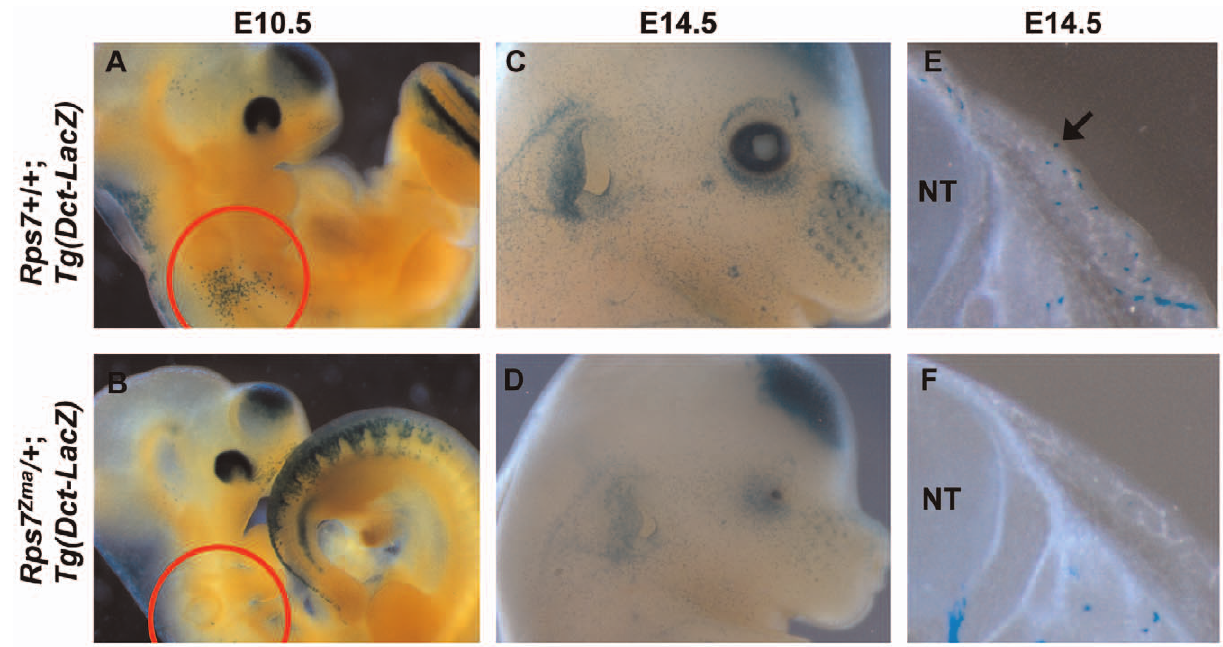
Figure 6. Melanoblast numbers are reduced in Rps7 Zma / + mutants. (A, B) In transgenic embryos carrying the melanoblast reporter Tg(Dct- LacZ) , whole mount staining showed that Dct-positive melanoblasts are significantly reduced at E10.5 in Rps7 Zma / + ; Tg(Dct-LacZ) mice (A) compared to Rps7 + / + ; Tg(Dct-LacZ) littermates (B). The reduction is noticeably apparent over the otic region (red circle). (C,D) Whole mount staining of E14.5 Rps7 Zma / + ; Tg(Dct-LacZ) embryos showed that these embryos (D) also display a reduction in melanoblasts relative to Rps7 + / + ; Tg(Dct-LacZ) littermates (C). The microphthalmia observed in Rps7 Zma / + mice is apparent in (D). (E, F) Consistent with the whole-mount observations, transverse vibratome sections through the trunk of E14.5 embryos revealed very few melanoblasts in the developing skin of Rps7 Zma / + ; Tg(Dct-LacZ) mice (F) as compared to the numerous melanoblasts seen in Rps7 + / + ; Tg(Dct-LacZ) littermates (arrow, E). Blue punctate staining indicates positive signal in melanoblasts. In all pairs of images, Rps7 + / + and Rps7 Zma / + are at the same magnification. NT=neural